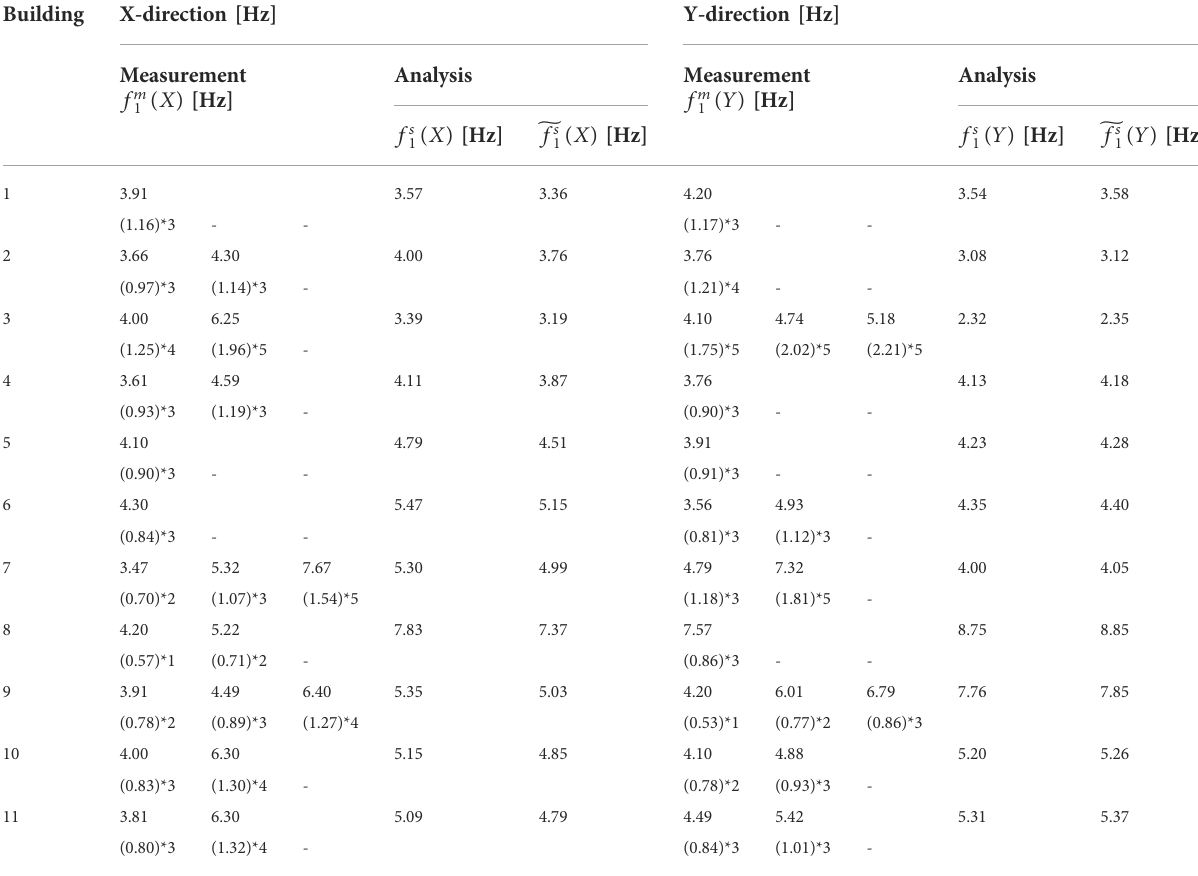
The values in parenthesis are the rates between the measured and calculated values, MSR (cid:1) f m 1 ( a ) / (cid:8) f s 1 ( a ) ,a (cid:1) XorY . The annotations from *1 to *5 are attached according to the range of the MSR: *1 Range 1 for MSR < 0 . 6, *2 Range 2 for 0 . 6 ≤ MSR < 0 . 8, *3 Range 3 for 0 . 8 ≤ MSR ≤ 1 . 2, *4 Range 4